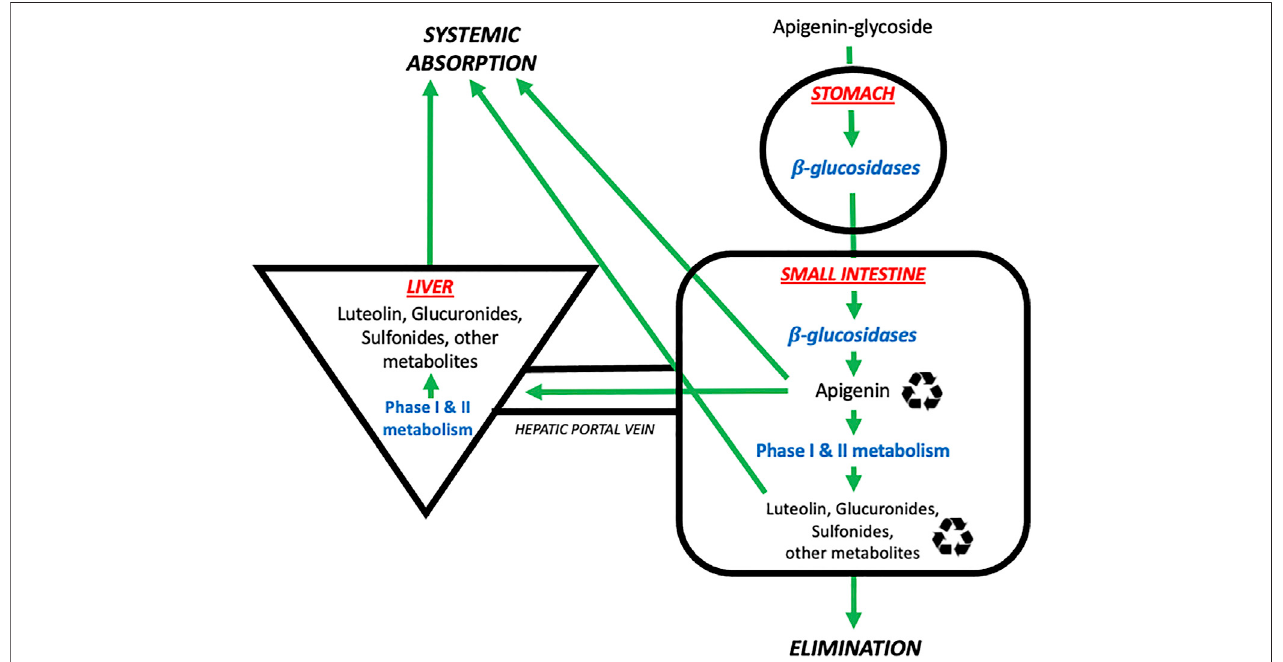
FIGURE 2 | The absorption, distribution, metabolism, and elimination of apigenin. Apigenin is present in the diet in glycosylated forms found in nature (e.g., 7-O- glucoside, 6-C-glucoside or 8-C-glucoside). These glycosides are then metabolized by β -glucosidases in the stomach and small intestines to generate free apigenin (i.e., the aglycone form). Free apigenin can be directly absorbed systemically, or undergo downstream phase I and II metabolism in the small intestines and liver to generate hydroxylated metabolites such as luteolin, or glucuronidated and sulfonated metabolites. These metabolites enter four possible pathways: i) direct systemic absorption, ii) elimination (mostly via the urine, to a lesser extent the feces), iii) local enteric recycling, or iv) enterohepatic recycling via the bile. Denotes that molecules are subject to recycling through enteric and/or enterohepatic routes. Image adapted from (Thilakarathna and Rupasinghe,